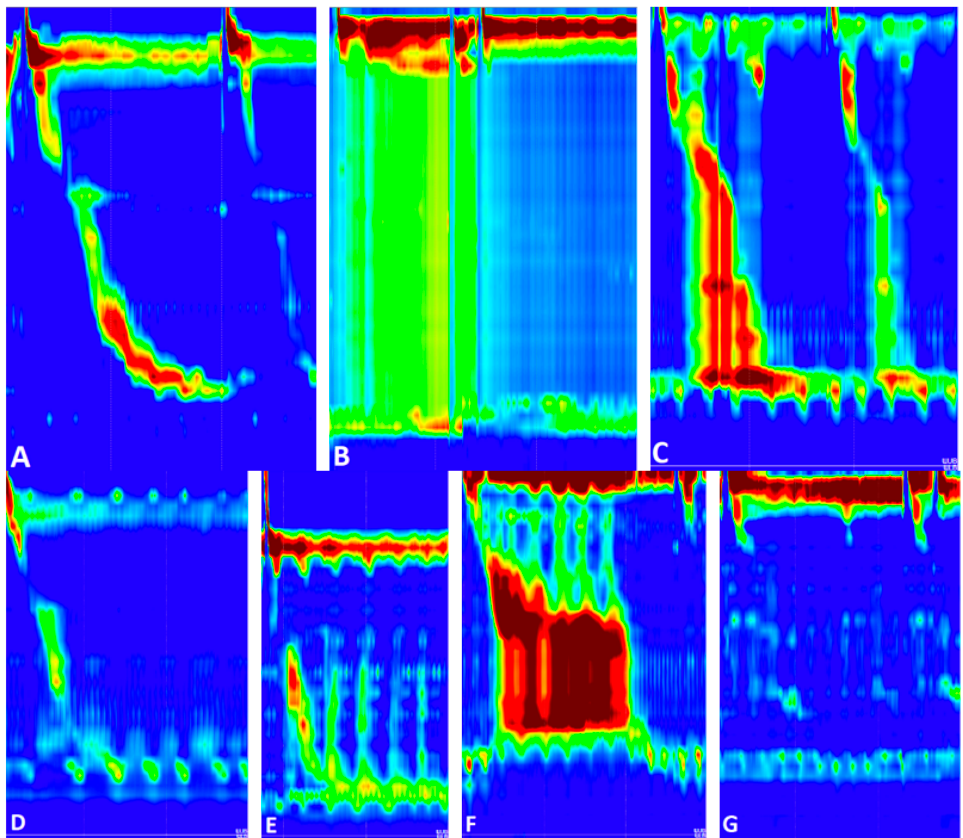
Figure 2. Swallowing patterns: ( A ) Normal; ( B ) Panesophageal pressurization; ( C ) Premature contraction; ( D ) Hypotensive; ( E ) Fragmented contraction; ( F ) DCI greater than 8000 mmHg·cm·s; ( G ) Failed peristalsis.